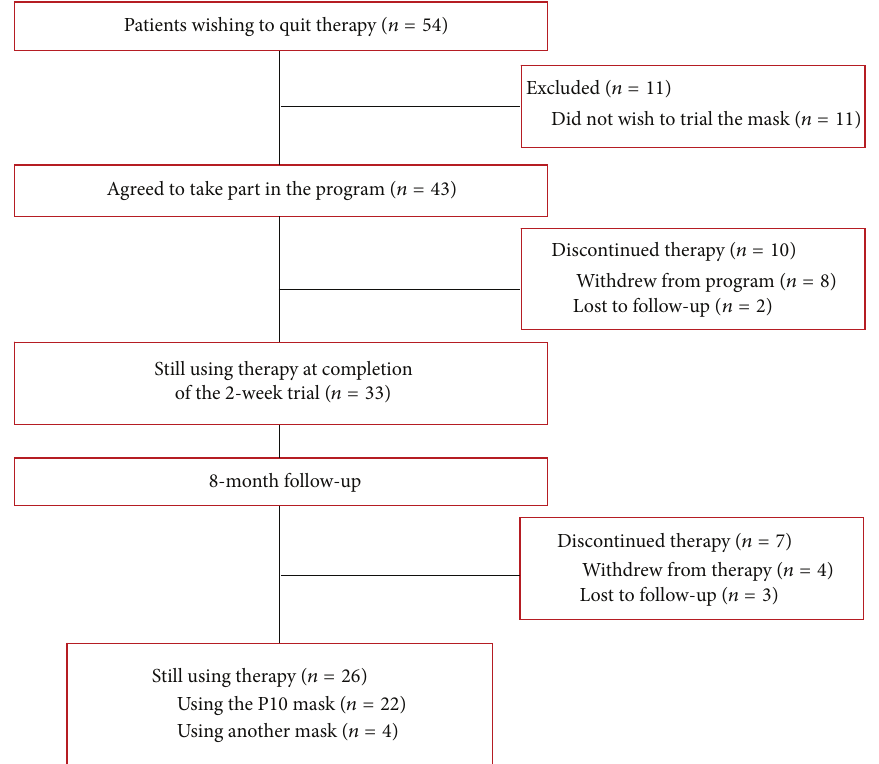
Figure 3: Results of program where patients wishing to quit therapy were offered a two-week trial of the new NPM (Group 5).